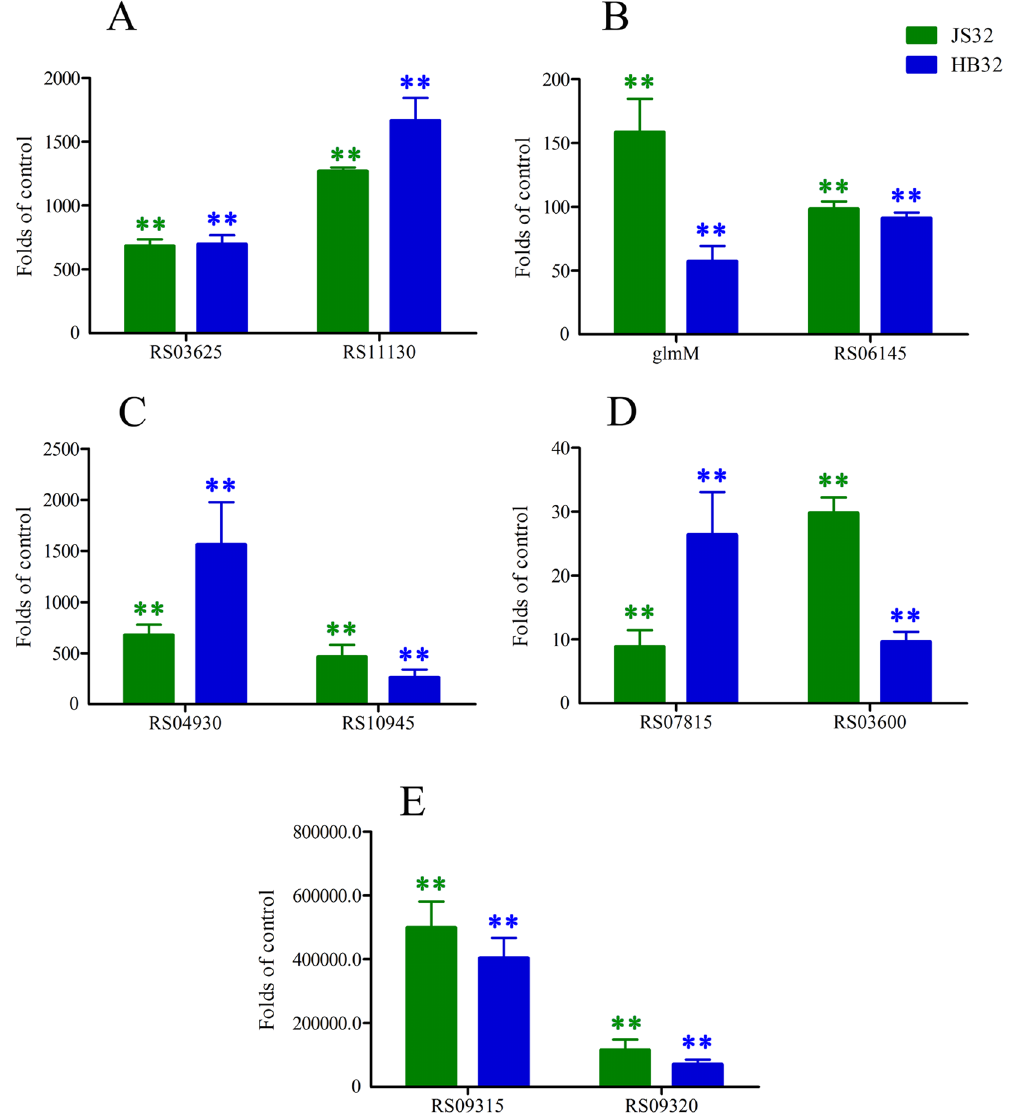
Figure 8. The differential expression on relative mRNA abundance of Ten genes in JS32 and HB32 compared with JS0135 . Control, the value = 1, Values are mean ± SD. * Presents statistically significant p ≤ 0.05, ** presents extremely significant p ≤